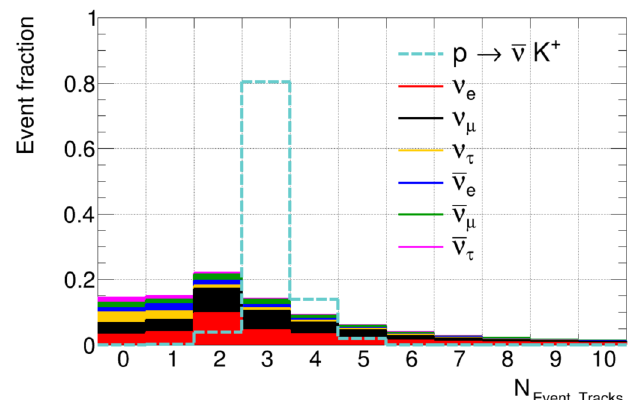
Figure 5 . Multiplicity distribution of reconstructed tracks with Q Track, LAr > 40 fC in the best view before event preselection in the reference signal and 10 megaton · years background samples.